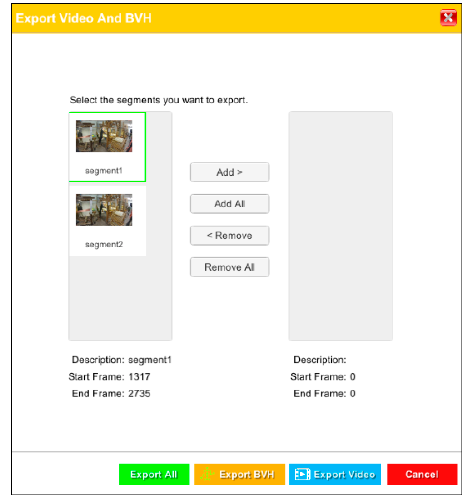
Figure 6. Export dialog.